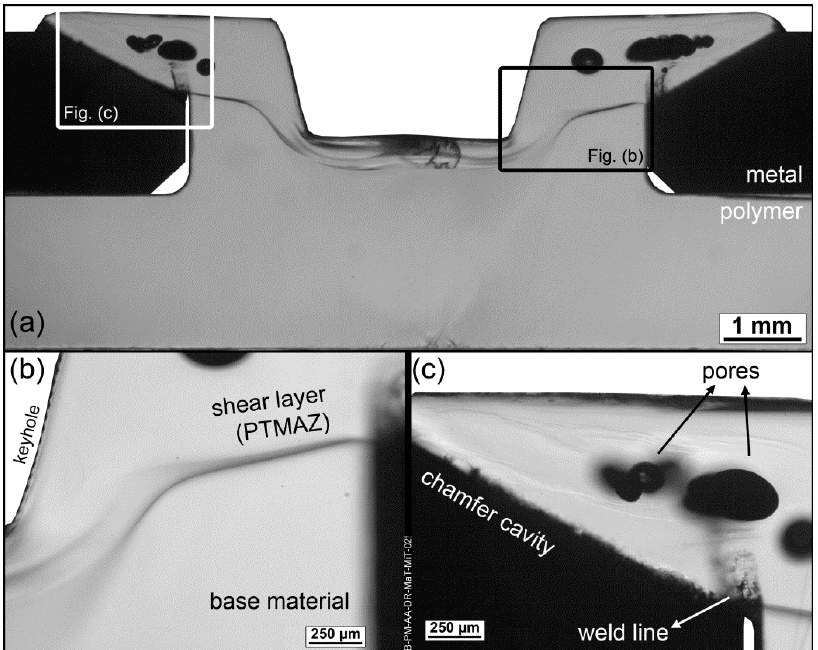
Figure 5. Microstructural features of an PEI-aluminum F-ICJ joint produced with a conical-pin tool and chamfer cavities. ( a ) Overview of joint cross-section; ( b ) polymer-polymer interface. ( c ) pores and remnant weld lines in the polymer thermo-mechanically-affected zone (PTMAZ; TLOM images). For processing conditions see Table 1. Adapted from [19].